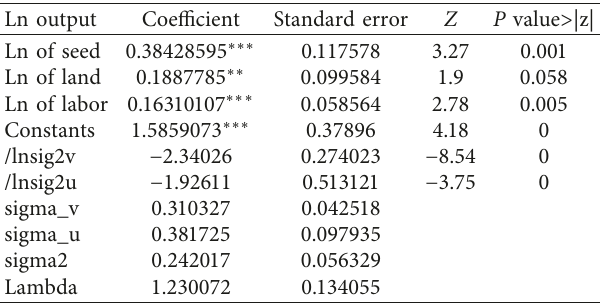
Table 1: Estimation of the Cobb–Douglas frontier production function.